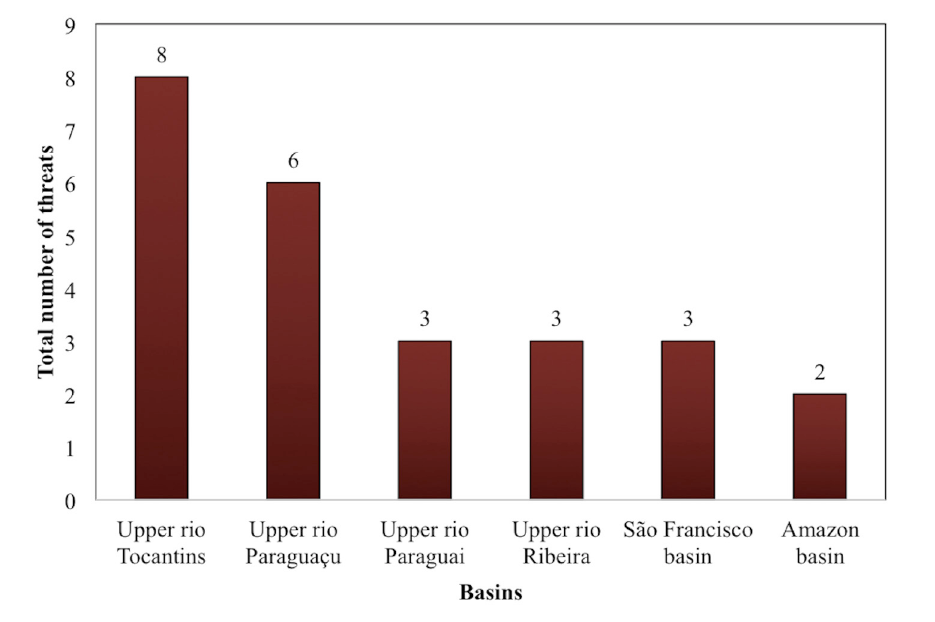
FIGURE 7 | Total number of threats recorded for each